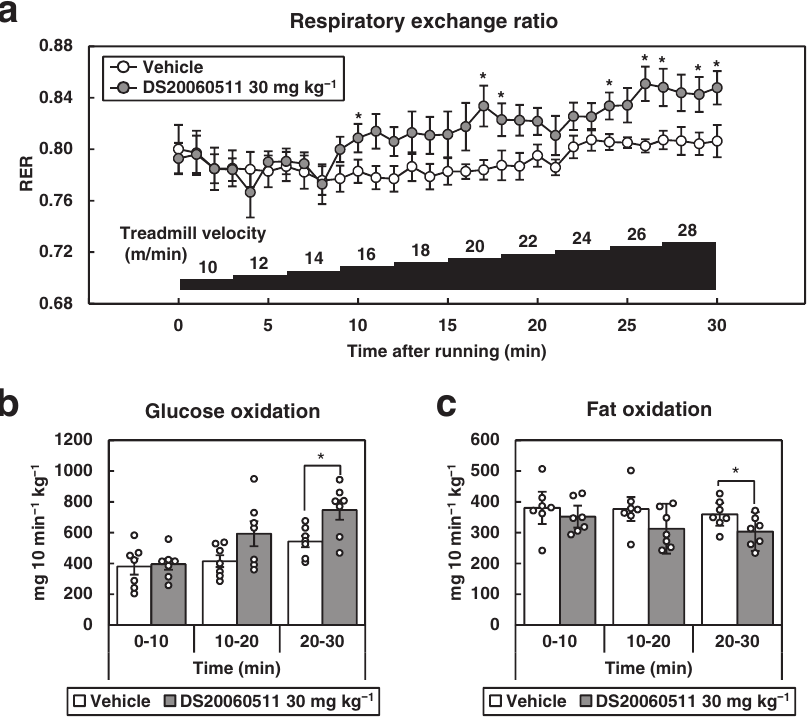
Fig. 5 DS20060511 increases glucose oxidation during exercise. a – c Respiratory exchange ratio (RER), estimated glucose oxidation, and fat oxidation during stepwise treadmill running in C57BL/6 mice (n = 7). Vehicle or DS20060511 (30 mg kg − 1 ) was given orally 15 min before starting running. Treadmill started from the velocity of 10 m min − 1 and increased by 2 m min − 1 each 3 min. Values shown are means ± SEM. * P < 0.05 vs. vehicle by the t -test.